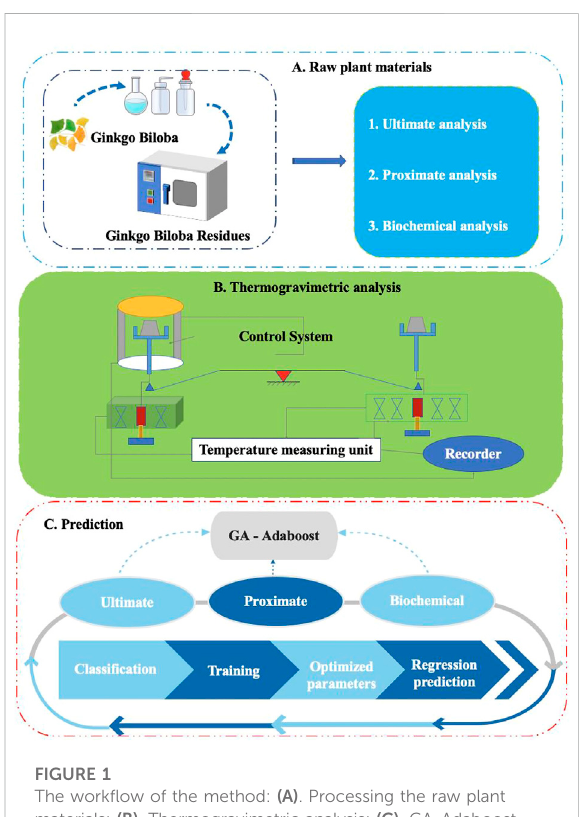
FIGURE 1 The work fl ow of the method: (A) . Processing the raw plant materials; (B) . Thermogravimetric analysis; (C) . GA-Adaboost based prediction.